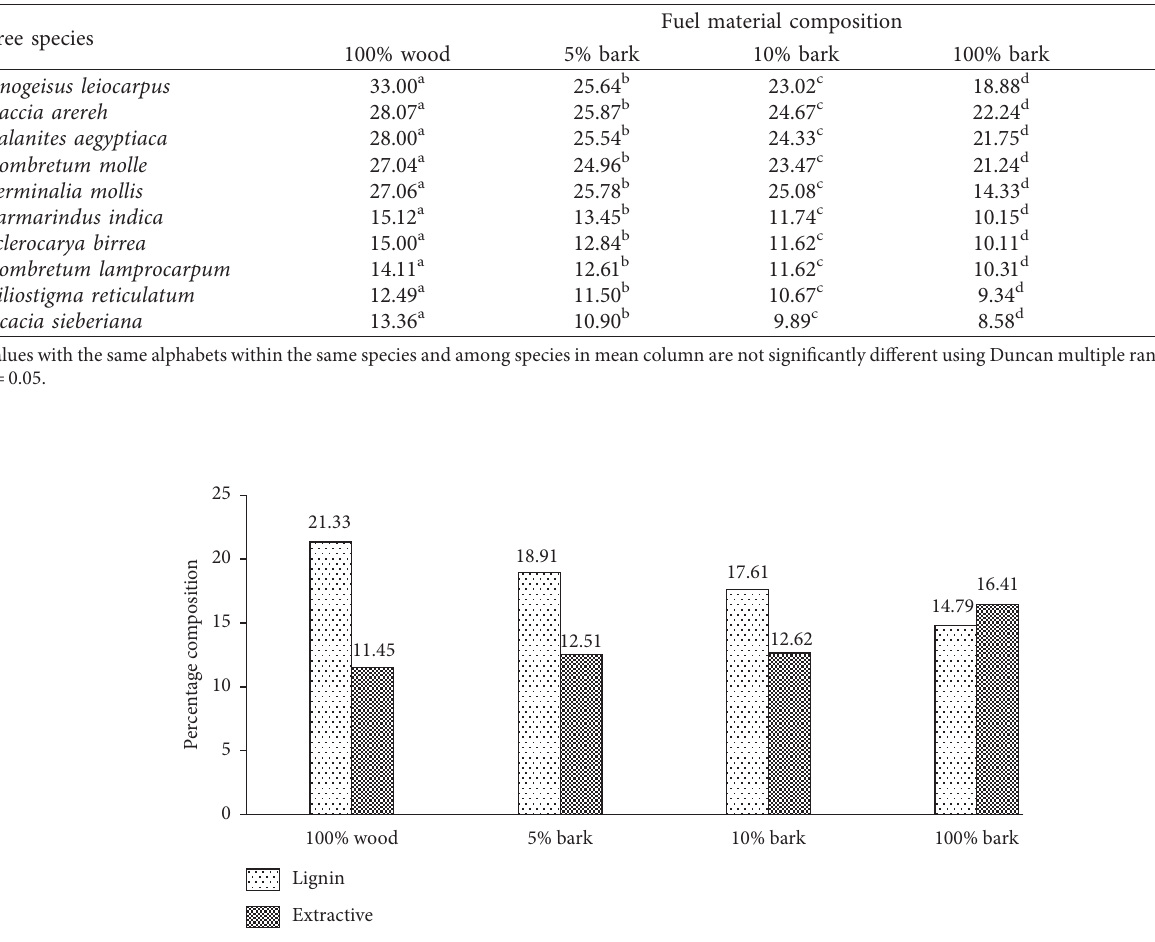
Table 5: Effect of bark inclusion on the lignin content (%) of selected fuelwood species.